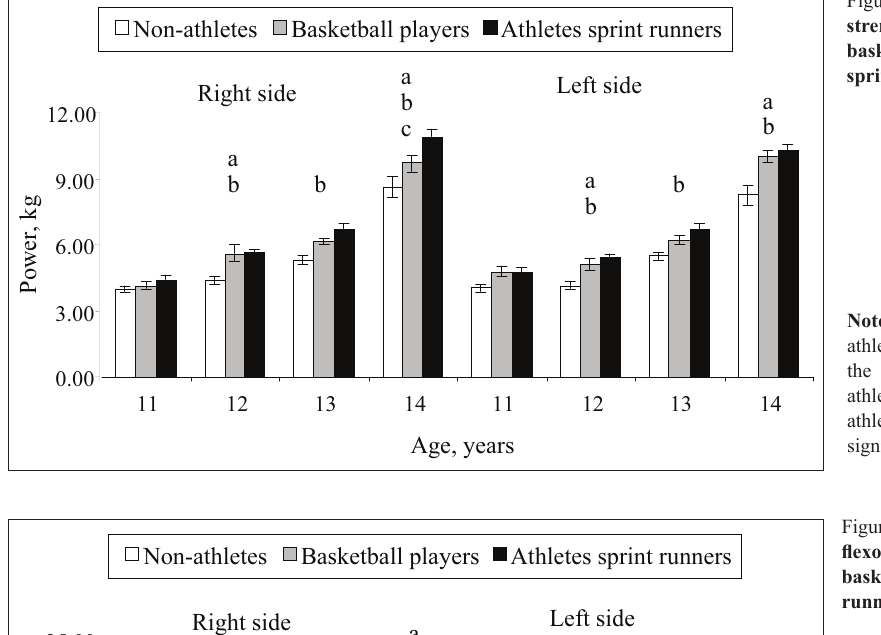
Figure 1. The results of arm levators strength in the non-athletes, sport basketball players and athletes sprint runners